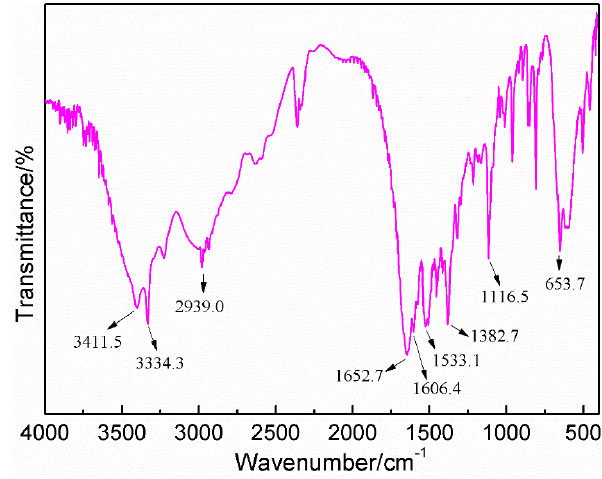
Figure 4. FT-IR spectrum of N -(2)- L -alanyl- L -glutamine.